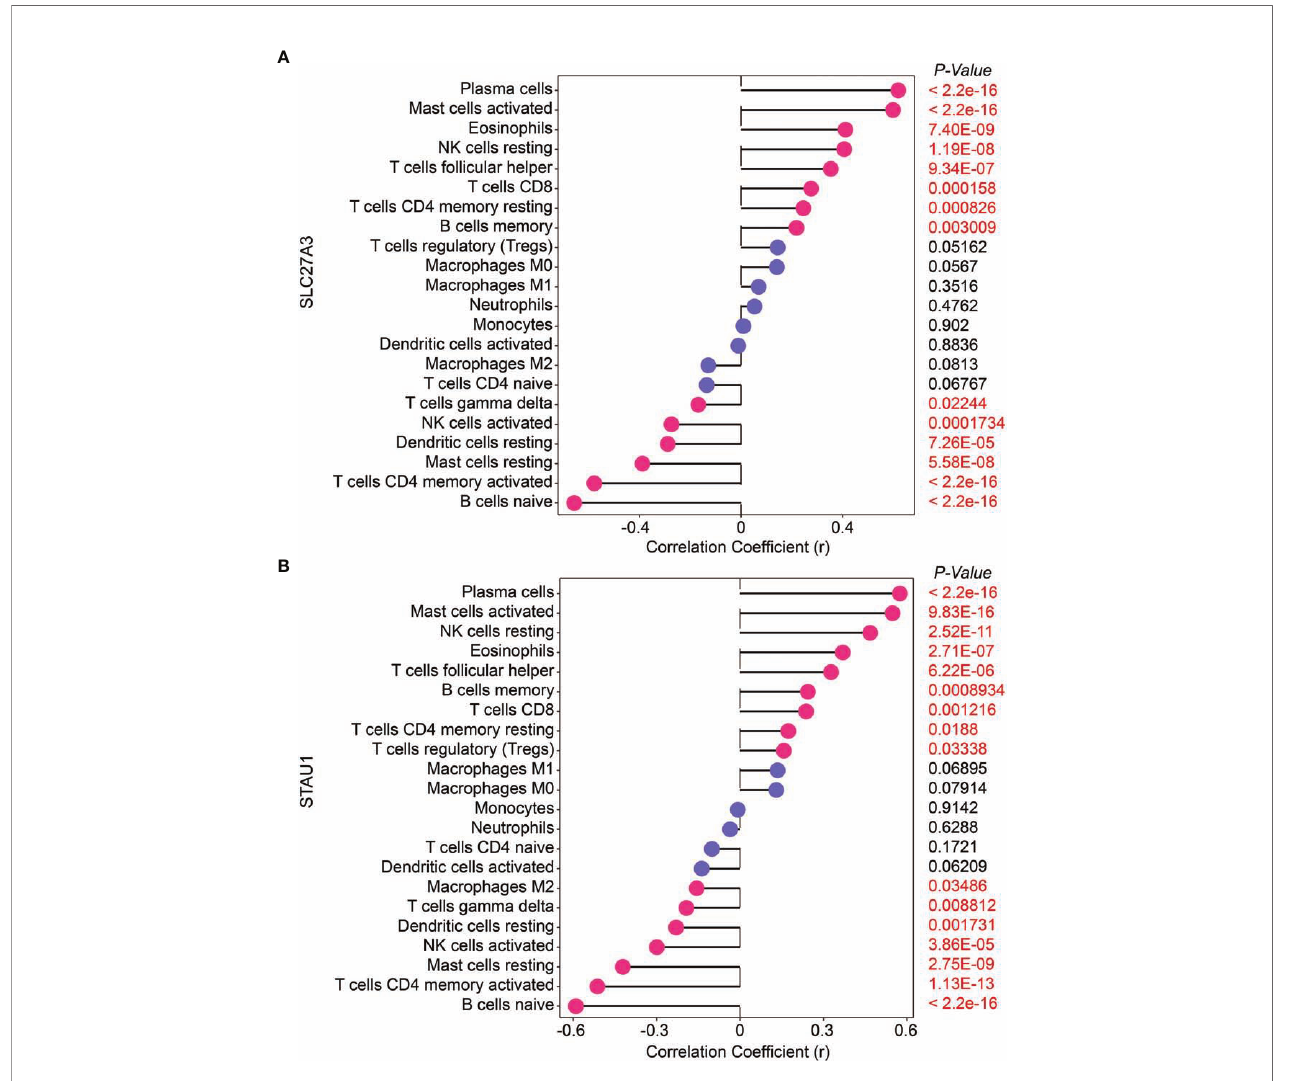
FIGURE 7 | Correlation of two diagnostic markers with 22 types of immune cell in fi ltration in chronic obstructive pulmonary disease. (A) SLC27A3; (B)